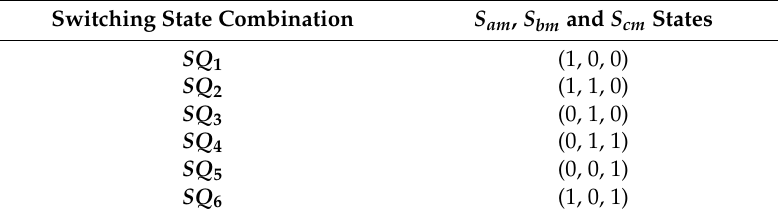
Table 1. Switching states vectors of matrix converter.